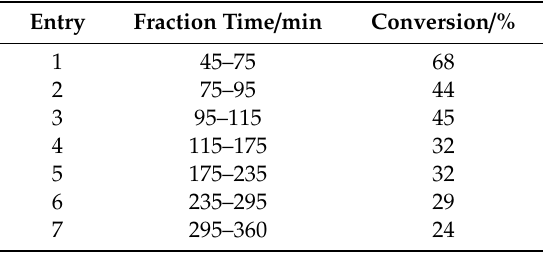
Table A14. Reduction of acetophenone ( 1 ) to 1-phenylethanol ( R )- 2 . Change from standard procedure: